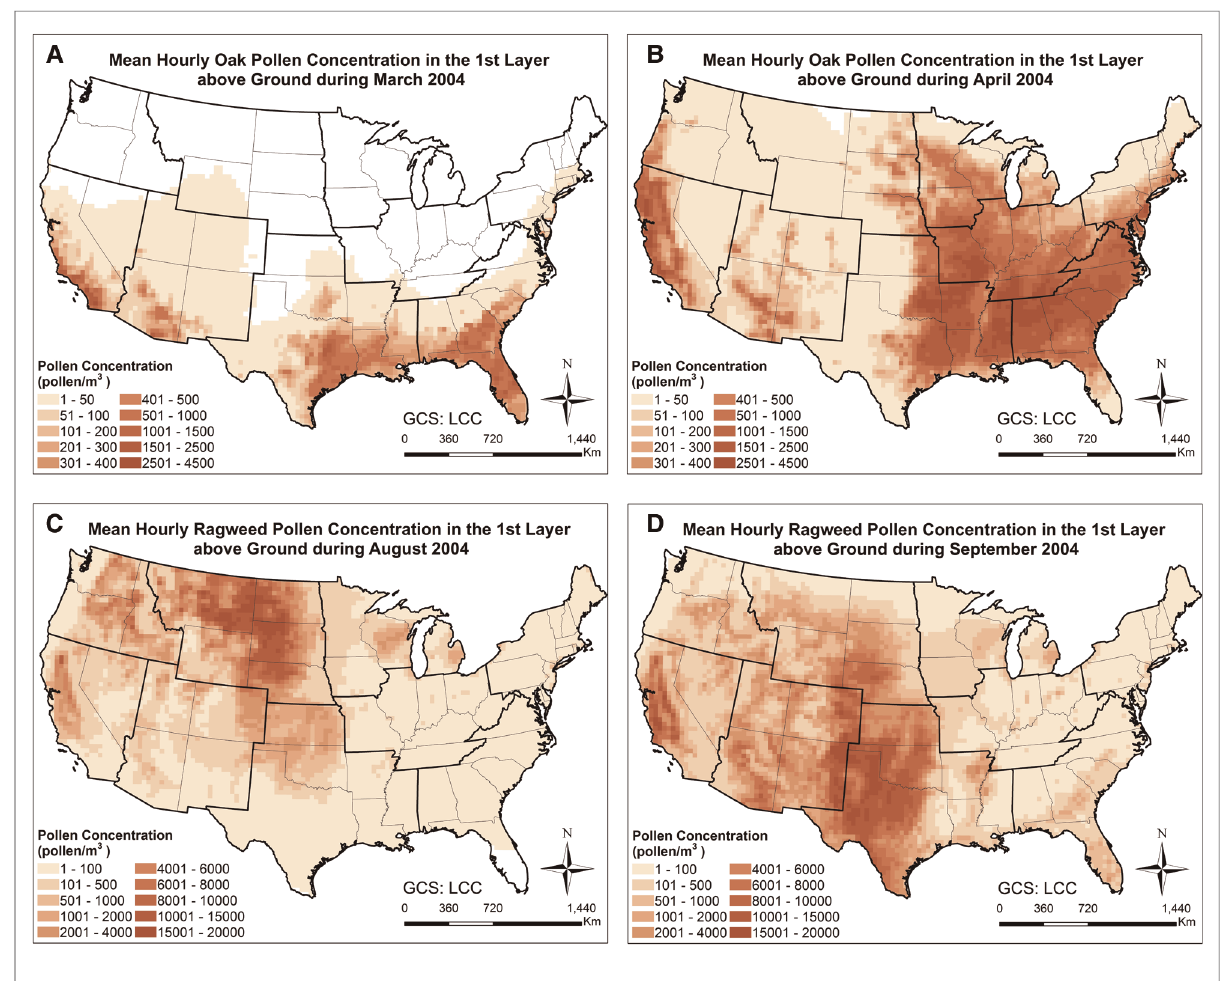
FIGURE 2 Spatial patterns of monthly mean concentrations of ( A ) oak pollen in March 2004; ( B ) oak pollen in April 2004; ( C ) ragweed pollen in August 2004; ( D ) ragweed pollen in September 2004, calculated using the CMAQ-Pollen